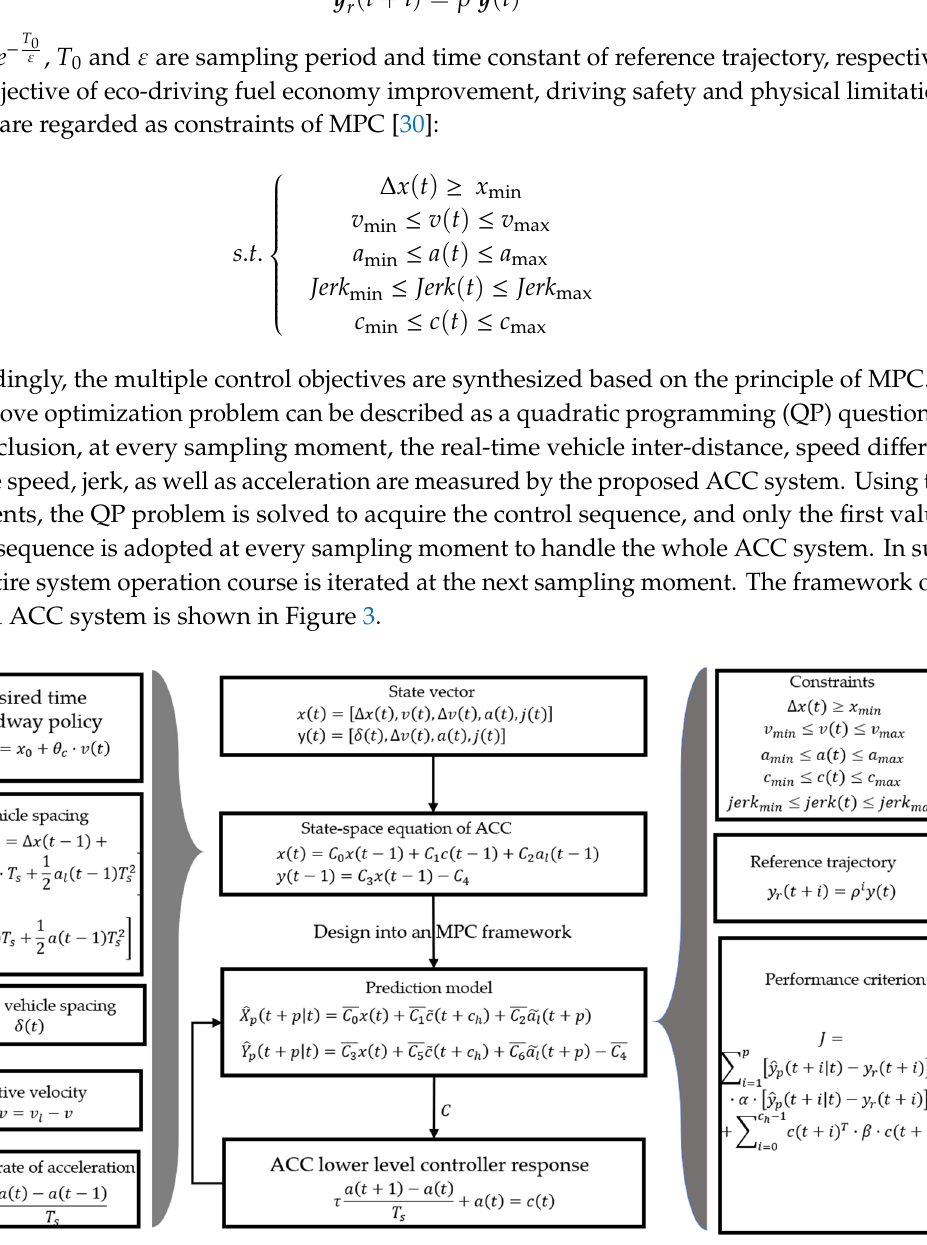
Figure 3. The framework of the model predictive control (MPC)-based adaptive cruise control (ACC) system .